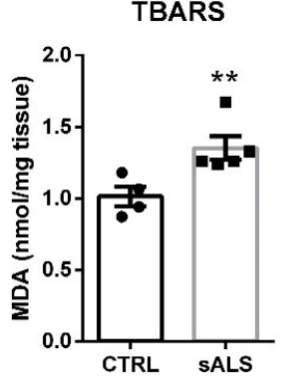
Figure 6. Increased TBARS levels in lumbar spinal cord in sALS patients. Thiobarbituric acid reactive substances (TBARs) representing malondialdehyde (MDA), resulting from oxidation of lipid substrates. Dots indicate the mean of n = 4 (controls) and n = 5 (sALS) samples ± SEM. Asterisk denote significant differences at ** p < 0.01 when comparing both groups according to the Student’s t